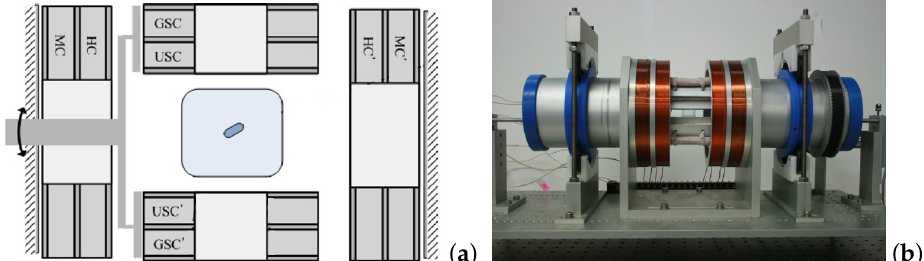
Figure 15. HMUGr EMA platform developed by Choi et al. [67]: ( a ) scheme of the concept; and ( b ) a photograph of the built